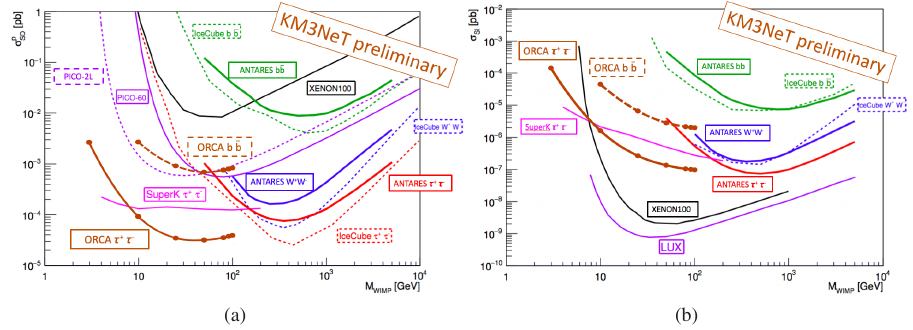
Figure 4 . SD (a) and SI (b) cross section sensitiviy for ORCA for 3 years of data taking compared with the other Dark Matter searches. Figures in Ref.